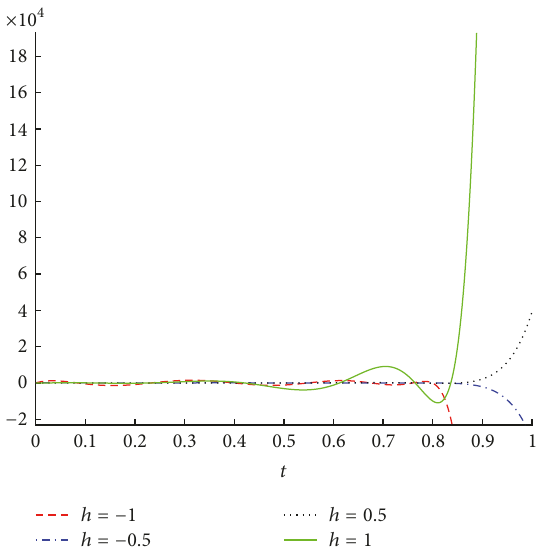
Figure 2: The 8th order analytical approximations for 𝑢(𝑡) given by HMA for Fabrizio-Caputo logistic differential equation.